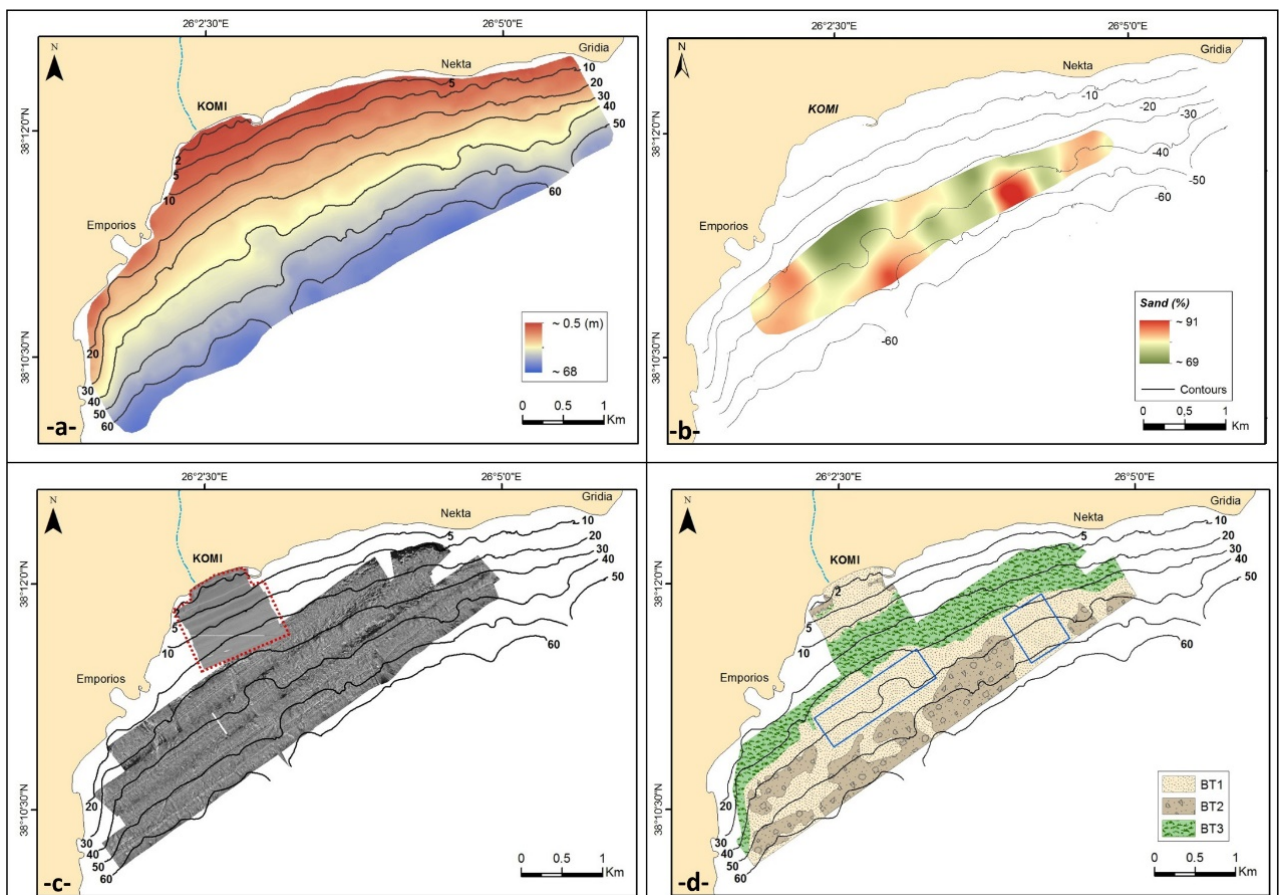
Figure 8. ( a ) Bathymetric chart of the study area, ( b ) distribution of sand percentage (restricted at the limits of the offshore sample locations) ( c ) SSS mosaic and ( d ) geomorphological map of the study area. Blue boxes designate areas where sand could potentially be extracted.